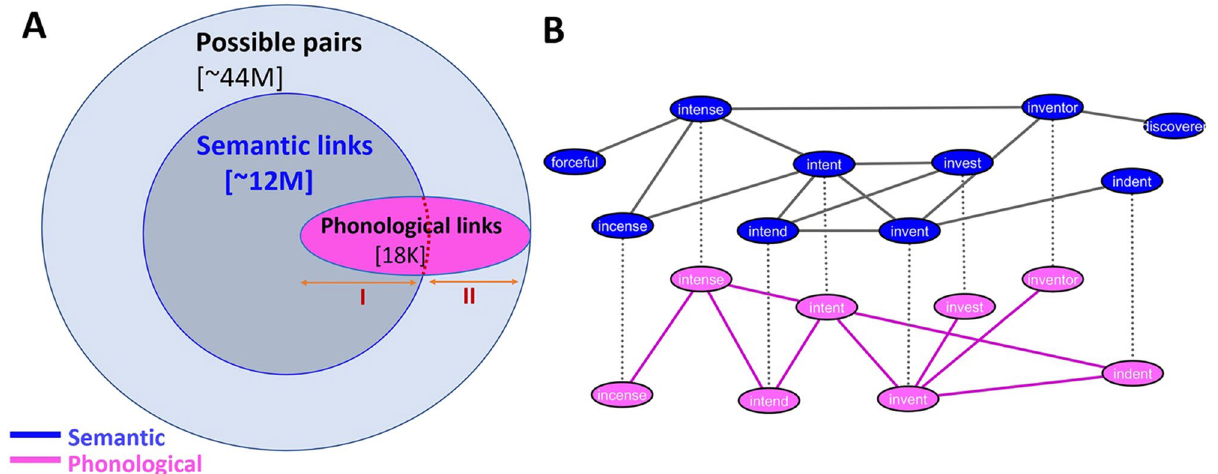
Figure 1. Multiplex network of semantic and phonological layers. ( A ) Illustration of the overlap across the (weighted) semantic layer and the (unweighted) phonological layer. ( B ) Illustration of the multiplex network with nodes and links across both semantic and phonological